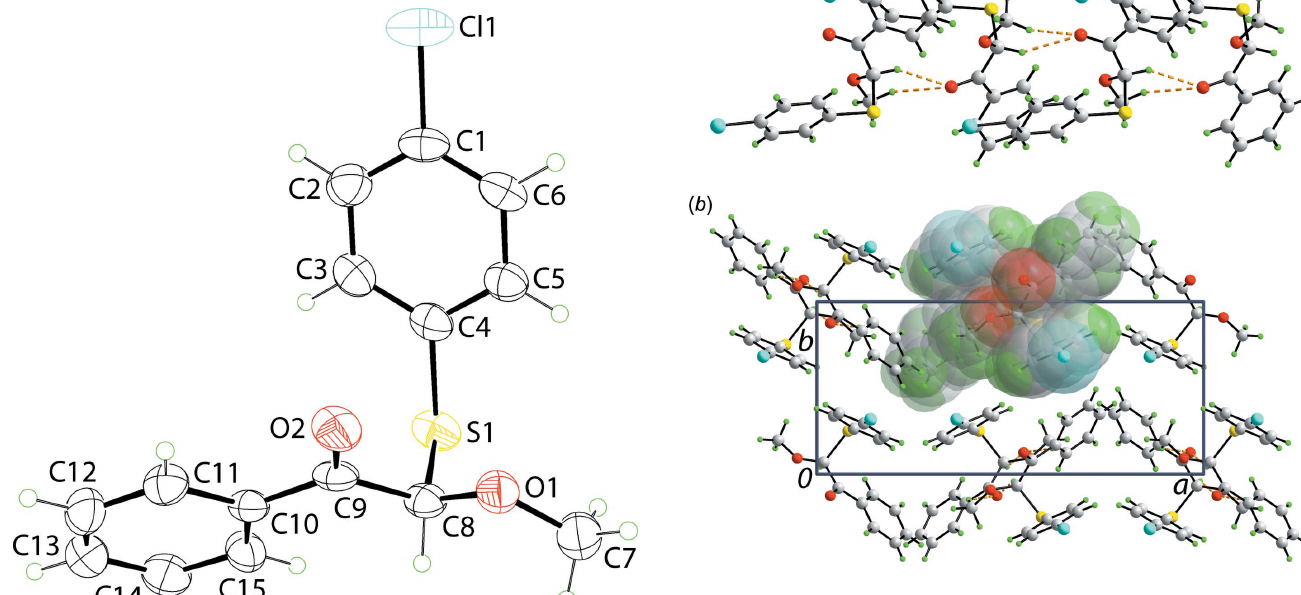
Figure 2 Molecular packing in (I): ( a ) view of the supramolecular chain parallel to the c axis and ( b ) view of the unit-cell contents shown in projection down the b axis; one chain is highlighted in space-filling mode. The C—H (cid:3)(cid:3)(cid:3) O contacts are shown as orange dashed lines.